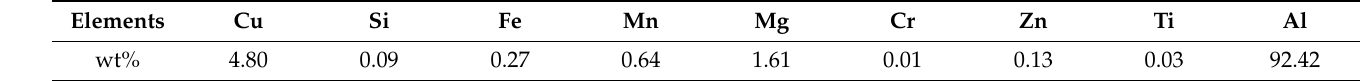
Table 1. Chemical composition of the purchased 2024 aluminum alloy